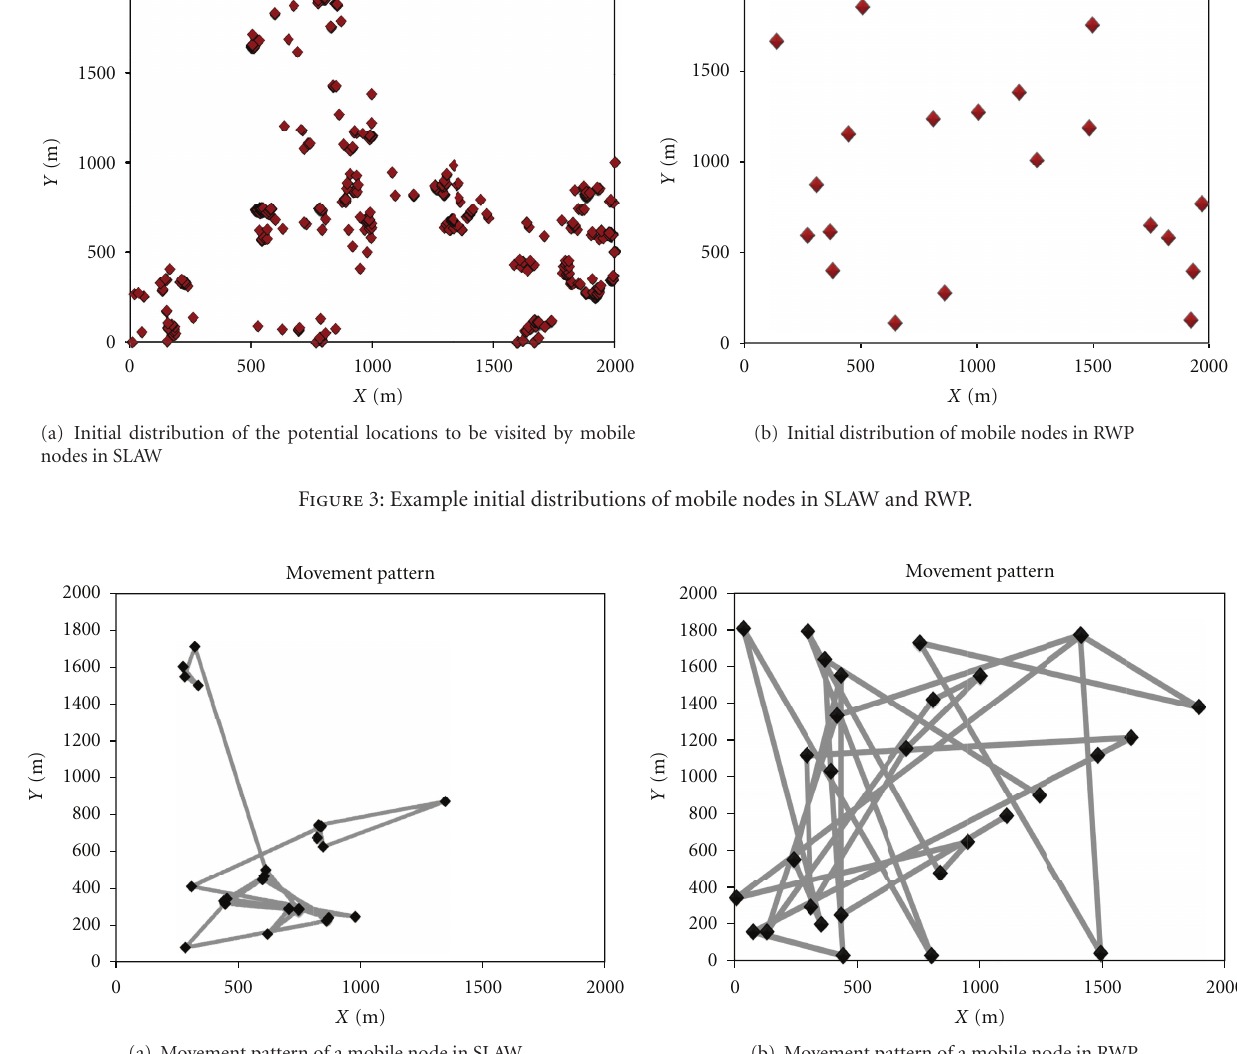
Figure 4: Example movement patterns in SLAW and